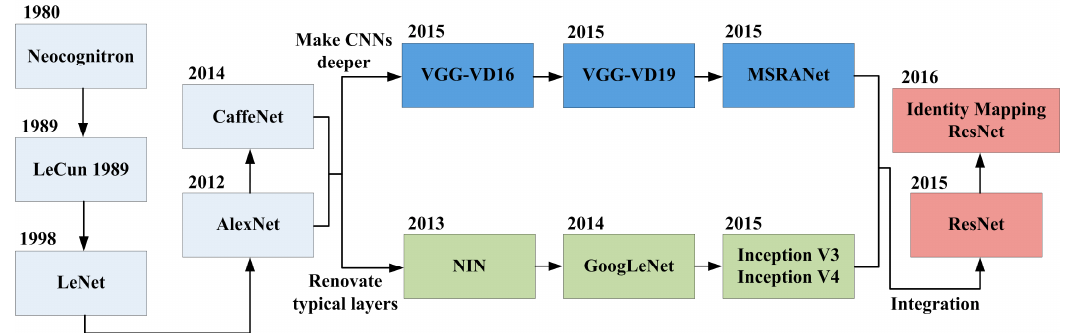
Figure 3. Evolution of the structure of convolutional neural networks.